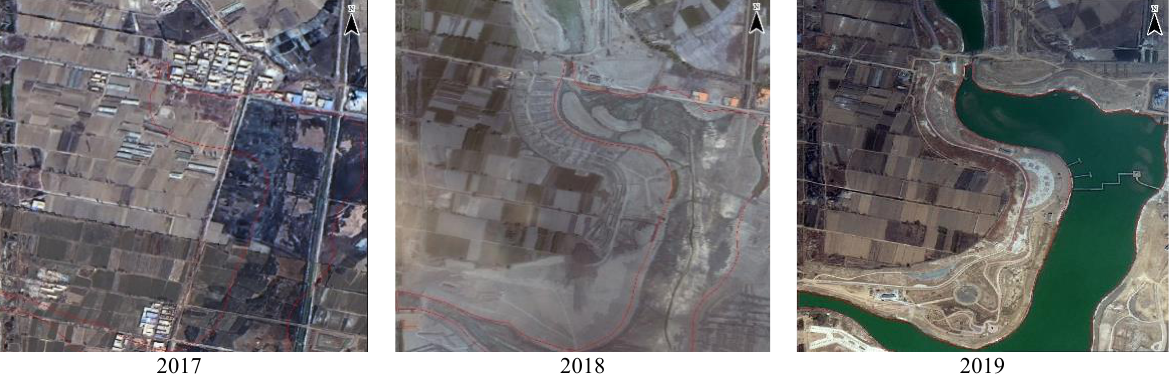
Figure 4 . Change time of artificial